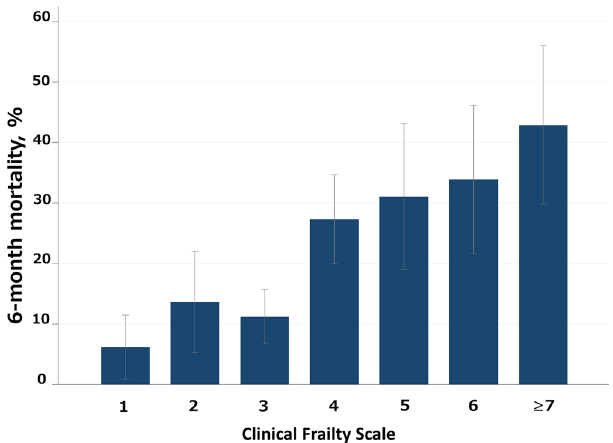
Figure 2. Six-month mortality by Clinical Frailty Scale score at the time of intensive care unit admission.